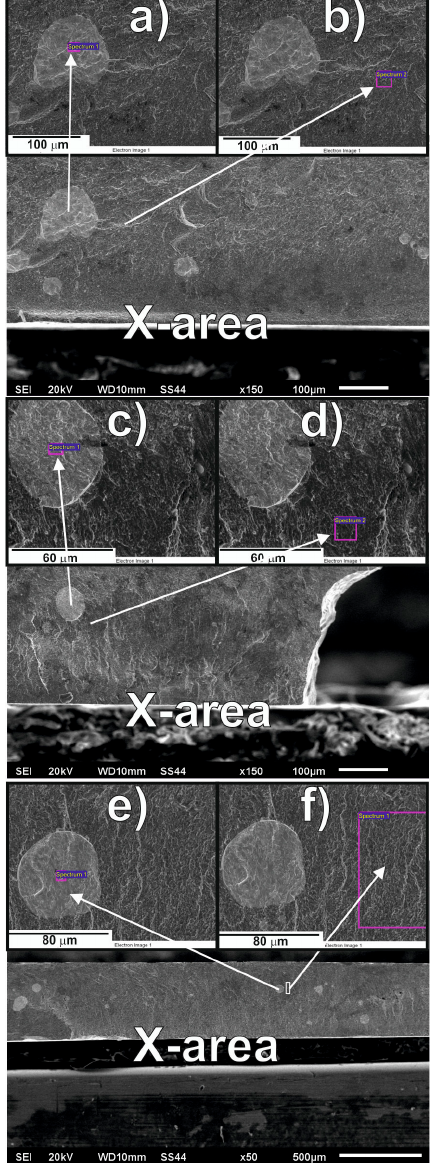
Figure 4. SEM images for the investigated alloys: ( a , b ) Fe 61 Co 10 B 20 Y 5 W 1 Pt 3 ; ( c , d ) Fe 61 Co 10 B 20 Y 4 W 1 Pt 4 ; ( e , f ) Fe 61 Co 10 B 20 Y 3 W 1 Pt 5